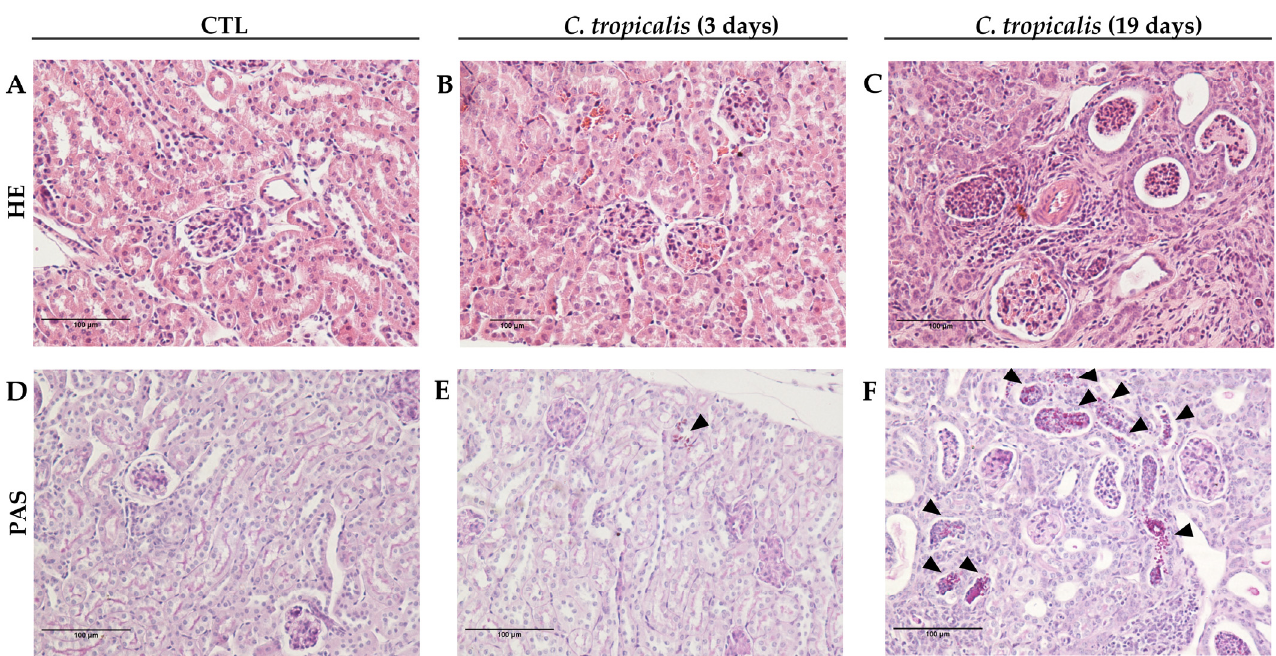
Figure 3. C. tropicalis growth within the kidneys of C57BL/6 mice. Female C57BL/6 mice were infected with 1 × 10 6 viable C. tropicalis yeasts and evaluated for inflammatory infiltrate ( A – C ) and presence of yeasts ( D – F ), indicated by arrows, in the kidneys. Representative images of each group.